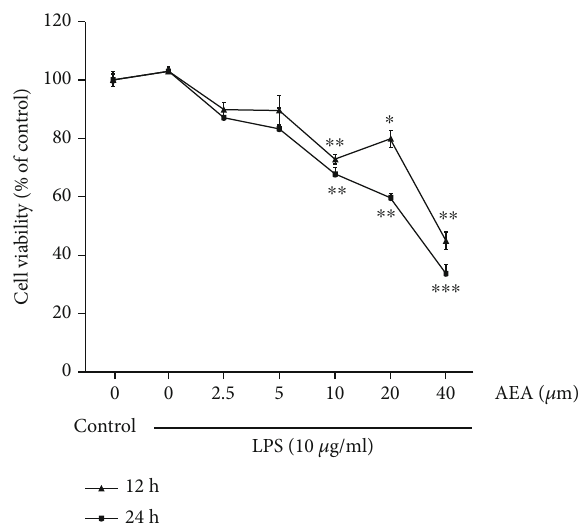
Figure 2: Determination of AEA cytotoxicity in LPS-stimulated AGS cells. Data are expressed as mean ± SEM of three independent experiments. ∗ Indicates signi fi cantly di ff erent compared to vehicle- treated cells, ∗ p < 0 : 05 , ∗∗ p < 0 : 01 , and ∗∗∗ p < 0 : 001